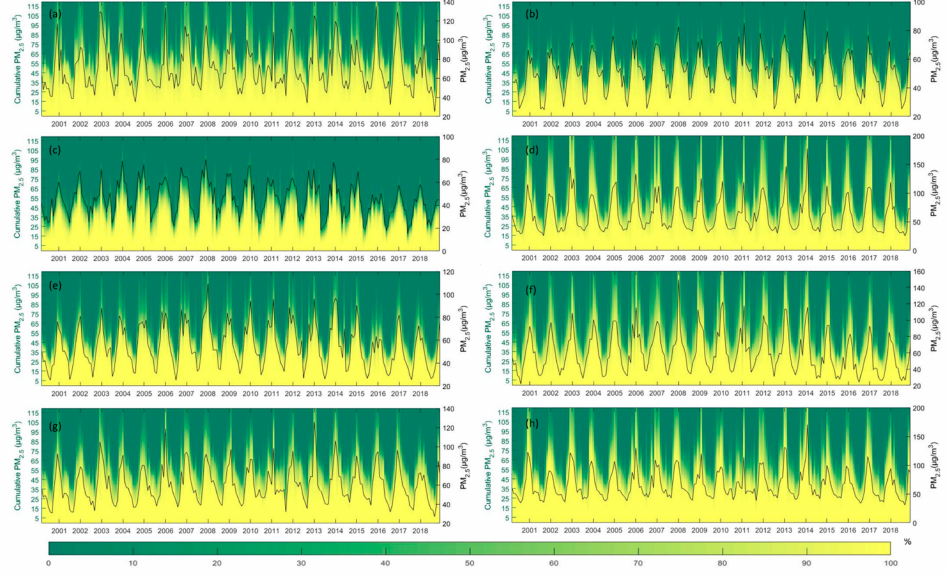
Figure A4. Temporal trends of monthly mean population-weighted PM 2.5 levels from March 2000